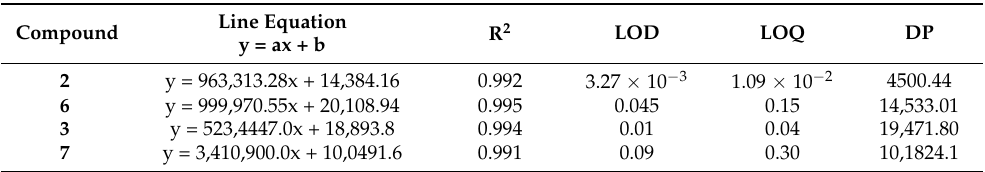
Table 3. Calibration data of the compounds (gallic acid ( 2 ), methyl gallate ( 6 ), myricetin-3-O- rhamnoside ( 3 ), and myricetin-3-O-(2”- O -galloyl)- α -rhamnopyranoside ( 7 )) to calculate the limits of detection (LOD) and quantification (LOQ) by the IUPAC method [33]. Line Equation Compound R 2 LOD LOQ DP y = ax + b